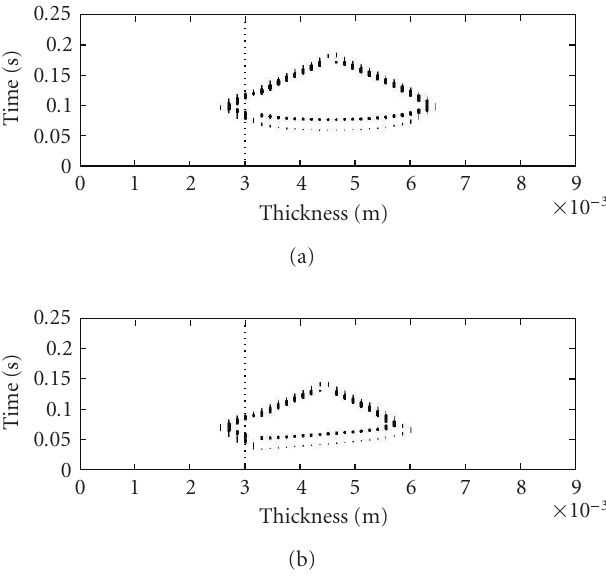
Figure 4.8. Example 2: extent of mushy and molten regions as a function of time for R g = 0 (a), R g = 10 − 9 initially (b). Darker markers indicate molten zone; lighter markers indicate mushy zone. Dotted line indicates location of interface.